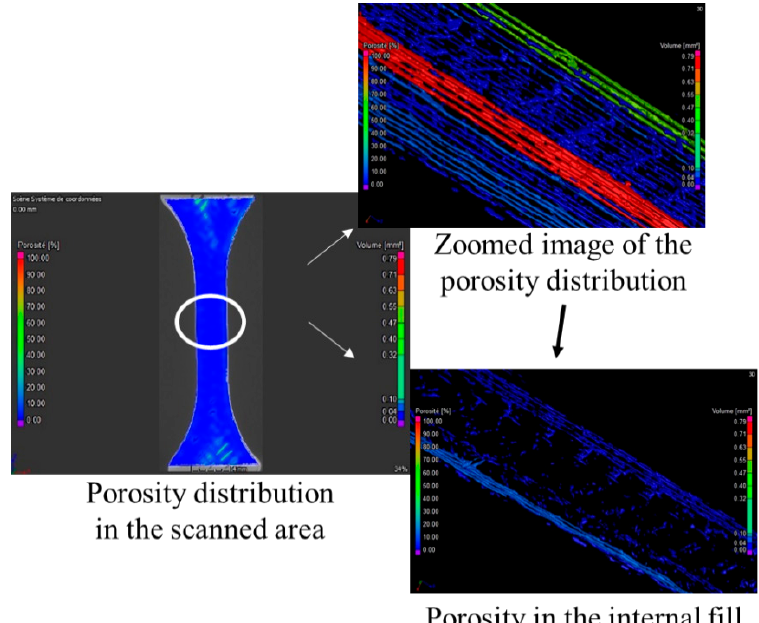
Figure 15. Example of the porosity distribution between adjacent printed filaments at a nozzle temperature of 250 °C.